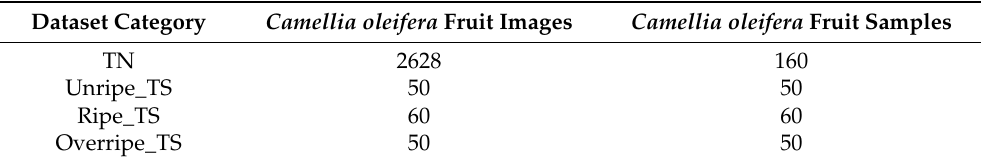
Table 1. Dataset